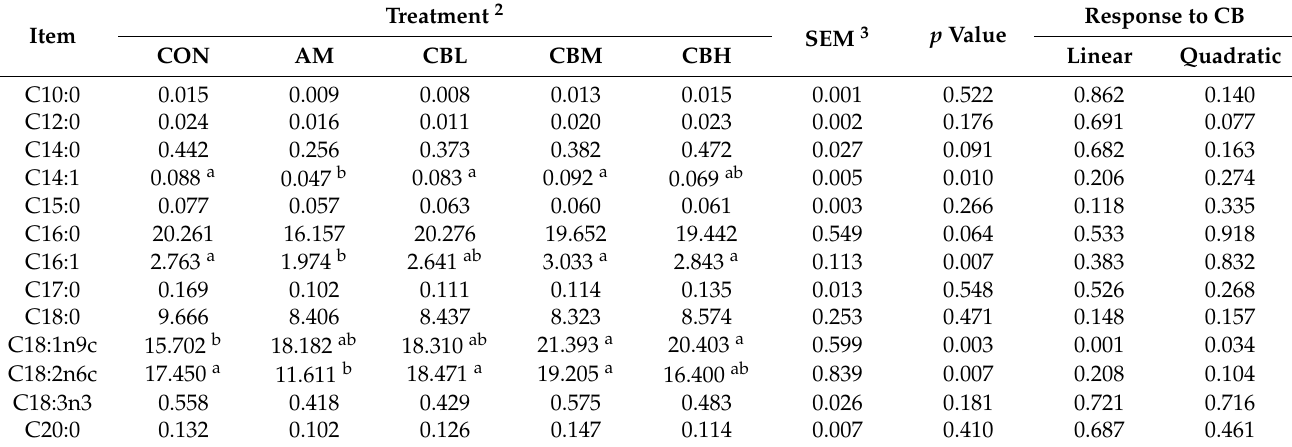
Table 6. Effects of C. butyricum on fatty acid composition (mg/g) in thigh muscle of broilers 1